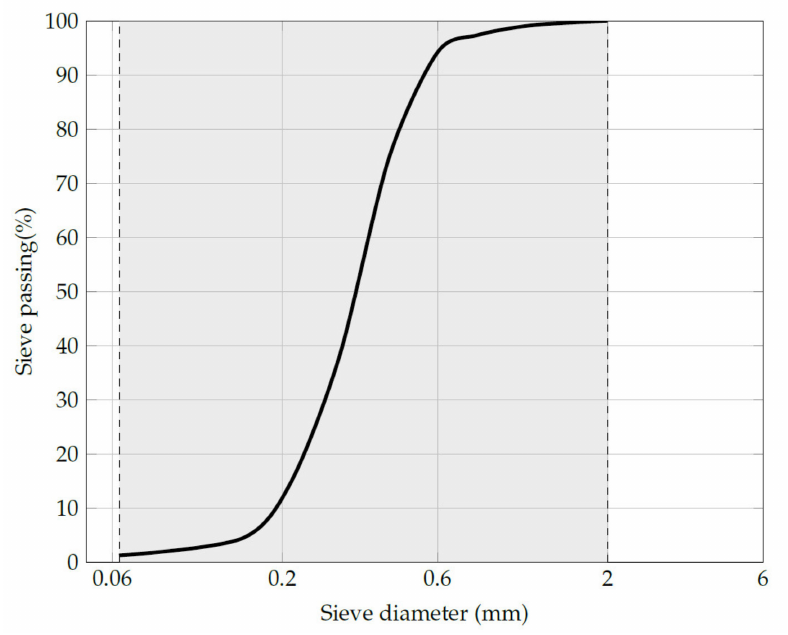
Figure 2. Grain size distribution curve of the Drava River sand built-in in the